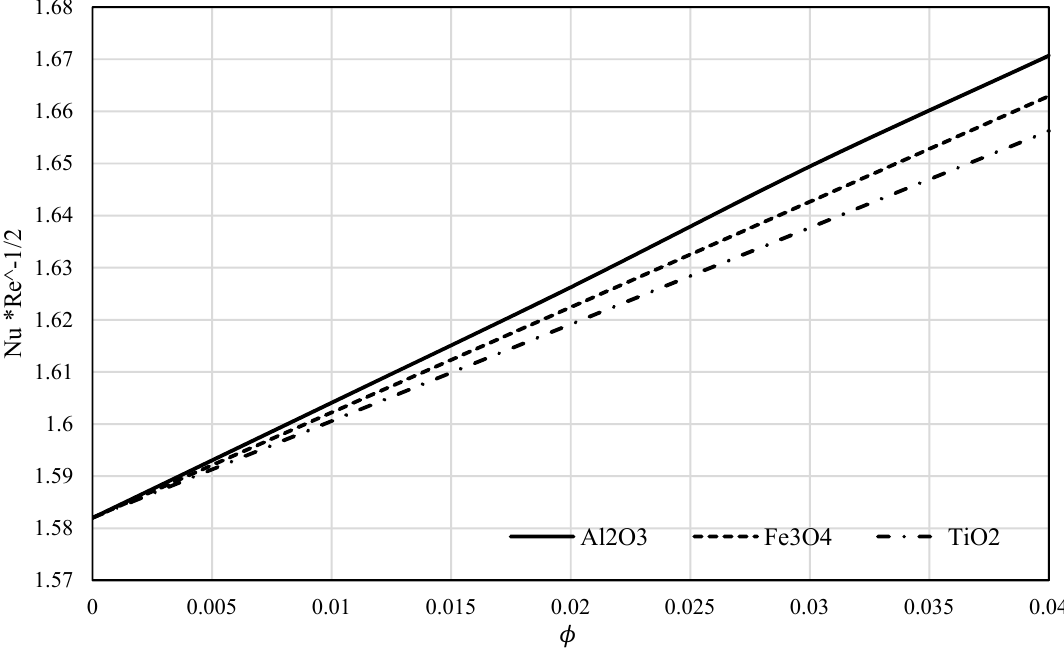
Figure 17. 𝑅𝑒 (cid:3051)(cid:2879)(cid:2869)/(cid:2870) 𝑁𝑢 versus 𝜙 for all three nanofluids.